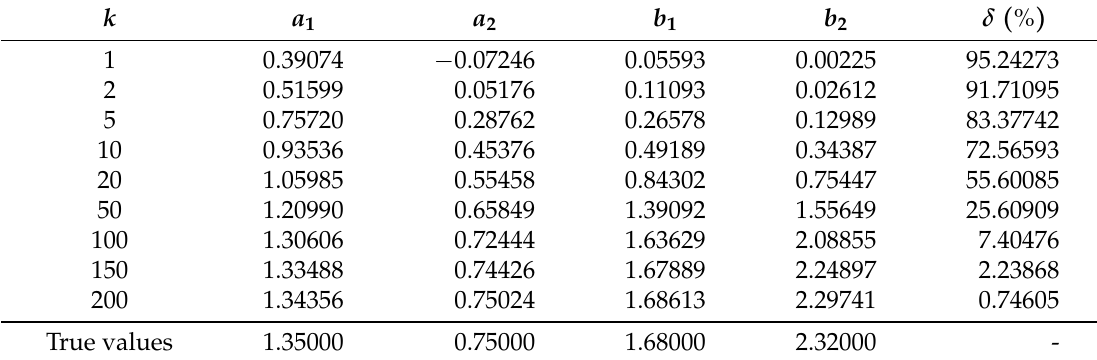
Table 3. The GI estimates and their errors with σ 2 = 1.00 2 .